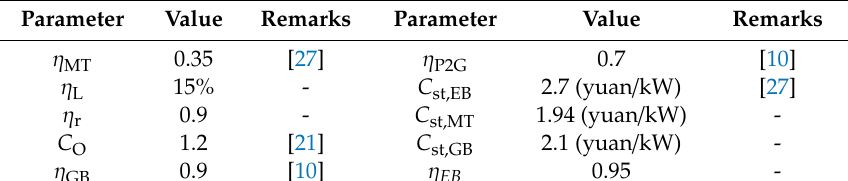
Table 3. The parameters for the case study.